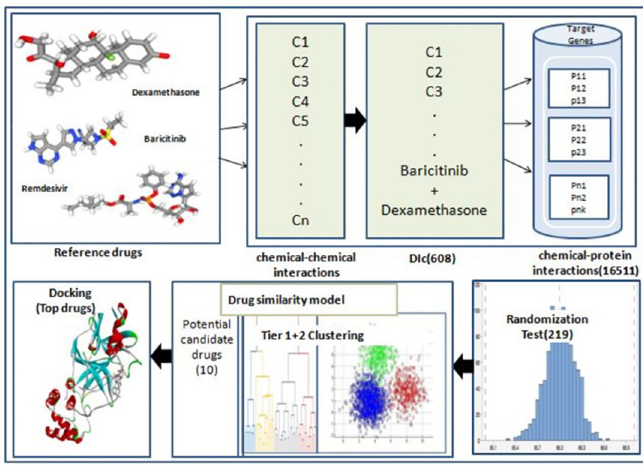
Fig 1. Stepwise workflow of repurposing three reference drugs as anti-COVID-19 drugs.